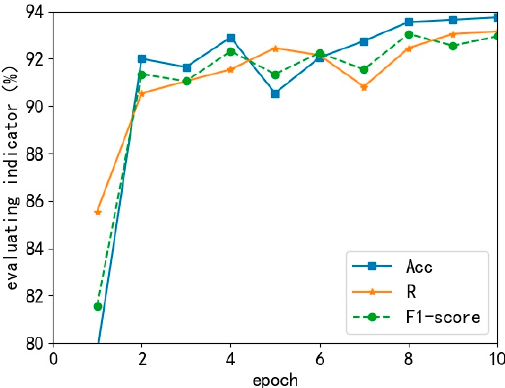
Figure 4. Changes in indicators of the TCN-BiGRU-DATT model.